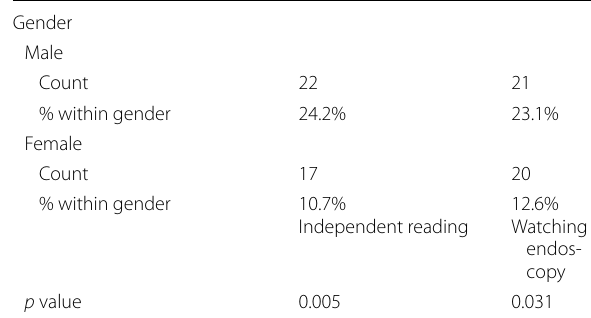
Table 3 Student’s preferred medical careers to pursue Medical career